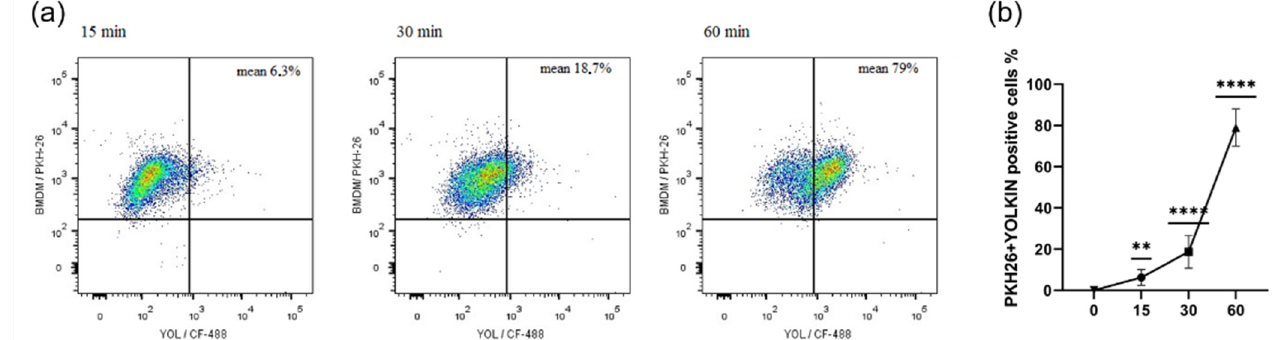
Figure 1. Analysis of yolkin uptake by BMDM cells over time. The cell membrane was stained with red fluorescent cell linker PKH26 prior to seeding on the tissue culture plate (3 × 10 5 /mL). Next, the cells were stimulated with labelled yolkin (100 µg/mL) for 15, 30 and 60 min and then analyzed using FACS. The quantity (%) of double-positive cells (PKH26 + YOLKIN) over time was measured. The results represent three independent experiments with